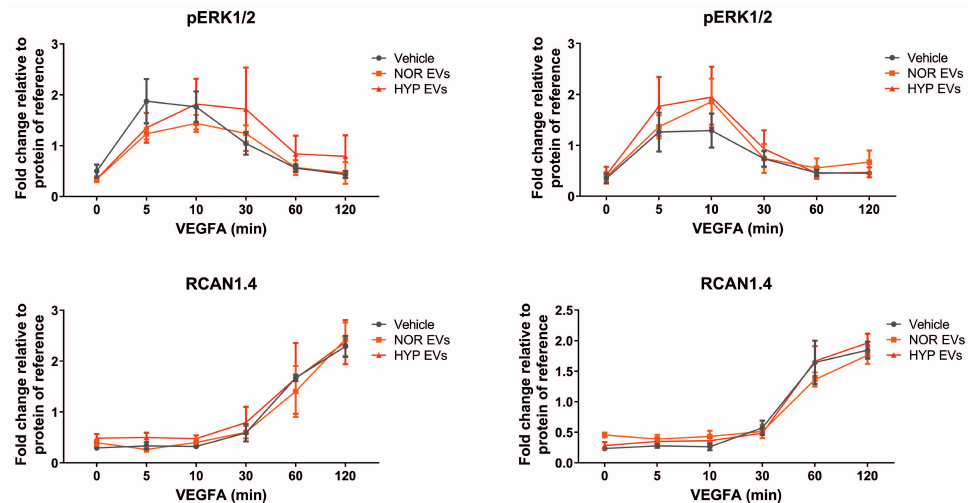
Figure 2. hUCMSC-derived EVs alter VEGFA 165 mediated VEGFR2 signalling. ( a ) Human Dermal Microvascular Endothelial Cells (HDMECs) starved overnight with Endothelial Cell Basal Medium (ECBM) containing 1% Foetal Calf Serum (FCS) were pre-treated for either 30 min or 24 h with 2 × 10 7 EVs from normoxic (NOR) or hypoxic (HYP) hUCMSCs. Following pre-treatment, cells were further stimulated with VEGFA 165 (50 ng/mL) for different periods of time (5, 10, 30, 60 or 120 min). Cells were lysed and immunoblotted for phospho-VEGFR2 (Y1175), total VEGFR2, phospho-AKT (S473), total AKT, phospho-ERK1/2 (T202/Y204), RCAN1.4 and Actin. ( b , c ) show quantification graphs of pVEGFR2, VEGFR2, pAKT, pERK1/2 and RCAN1.4 over time after 30 min ( b ) or 24 h ( c ) EV pre-treatment. Data is normalised relative to the protein of reference. Graphs show mean ± SEM of n = 4 ( b ) or n = 3 ( c ) independent experiments. Statistical analysis: Two-way ANOVA followed by Tukey’s post hoc test, where * p < 0.05, ** p < 0.01 and *** p <